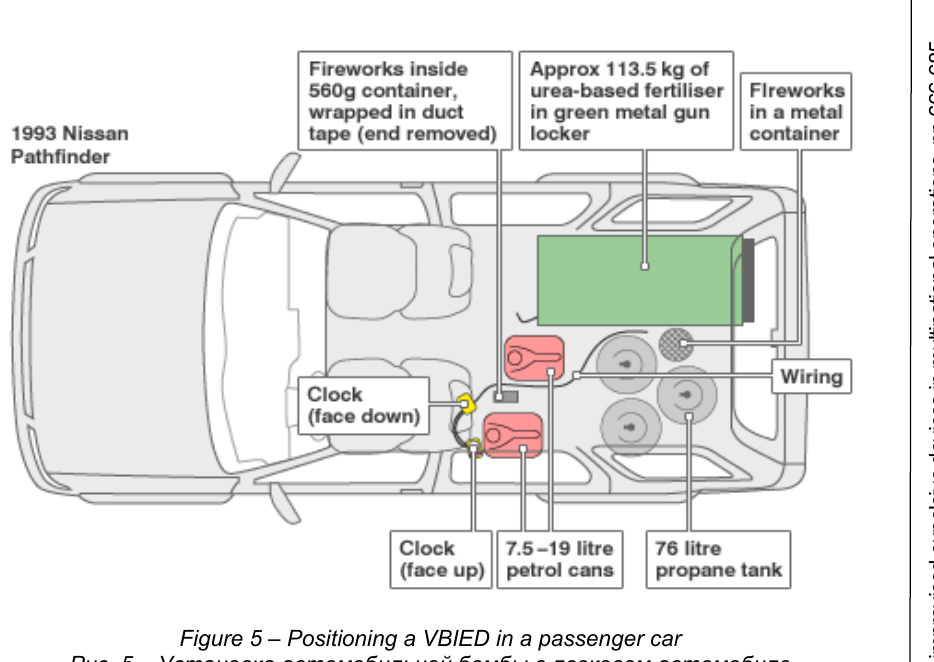
Figure 5 – Positioning a VBIED in a passenger car Рис . 5 – Установка автомобильной бомбы в легковом автомобиле